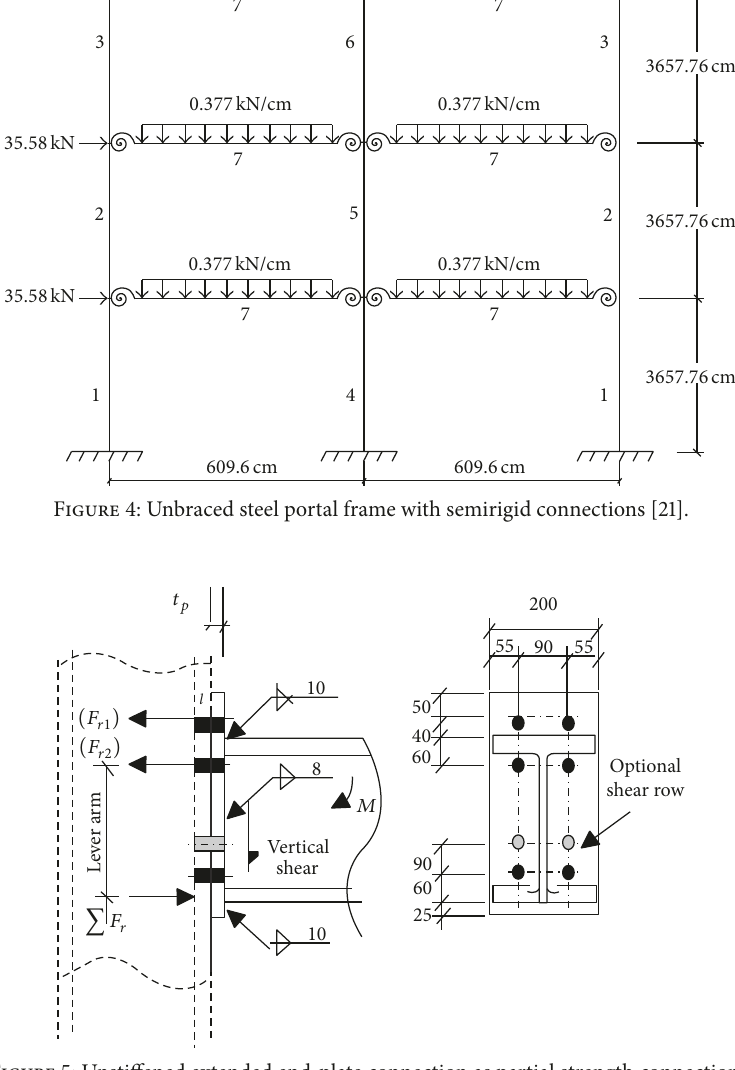
Figure 5: Unstiffened extended end-plate connection as partial strength